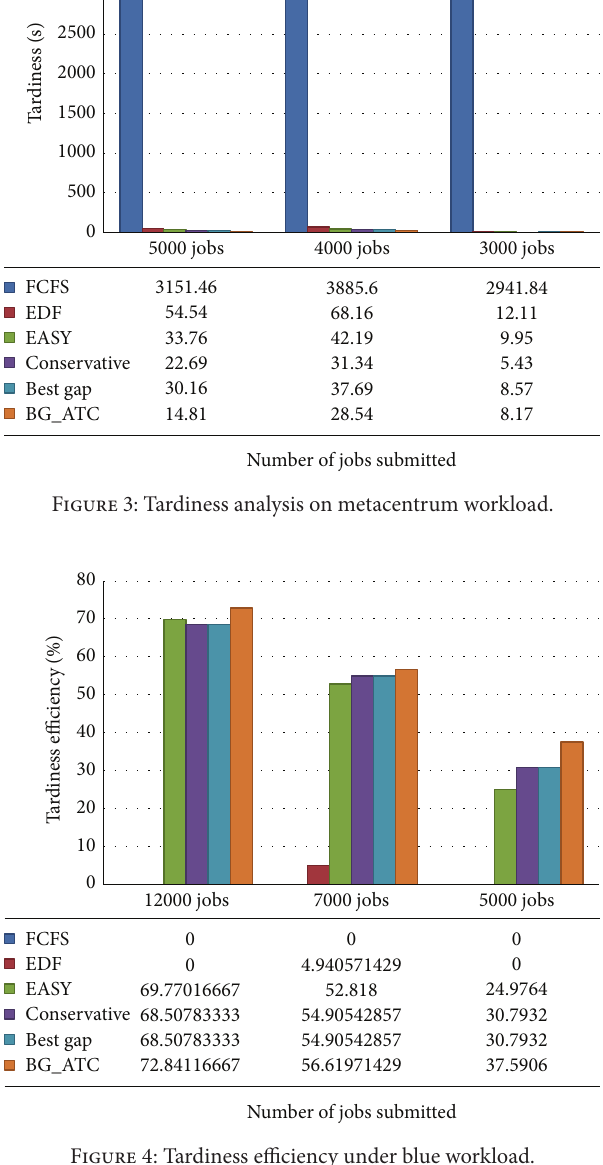
Figure 4: Tardiness efficiency under blue workload.